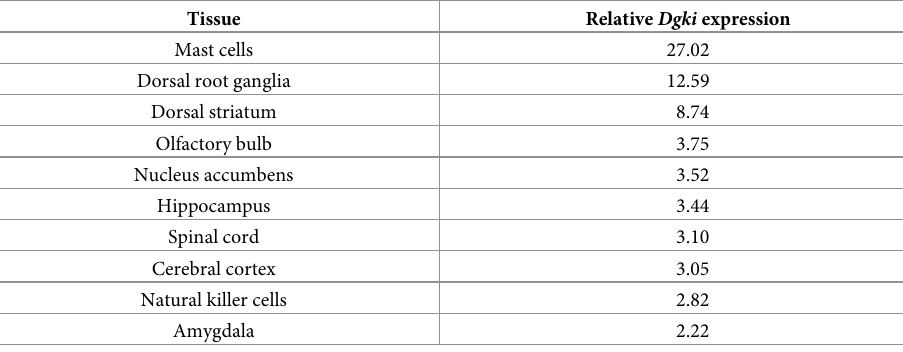
Table 1. Dgki is highly expressed in neuronal tissues and mast cells.